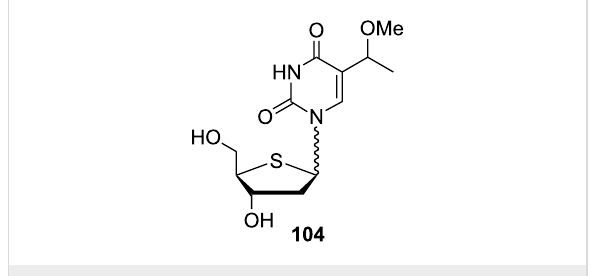
Figure 15: 2'-Deoxy-5-(1-methoxyethyl)-4'-thiouridine ( 104 ).